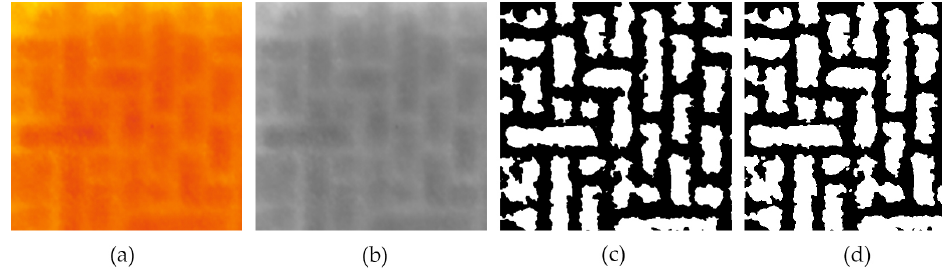
Figure 7. Identified texture of random masonry sample: ( a ) thermographic image, ( b ) surface temperature as greyscale values T i ( x , y ) , ( c ) black and white image after thresholding b i ( x , y ) , ( d ) identified texture after erosion and dilation, b d ( x , y )